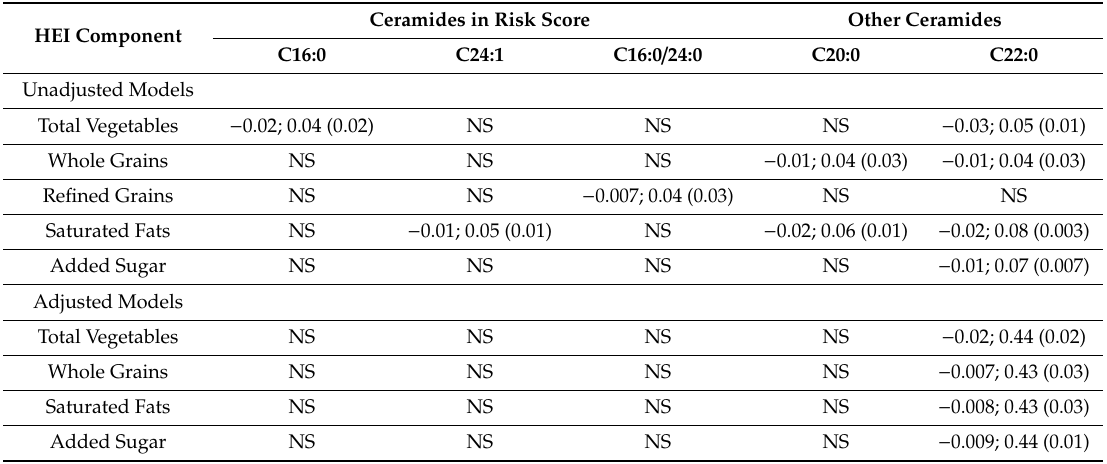
Table 3. Associations between the Healthy Eating Index (HEI-2015) components and ceramides. HEI